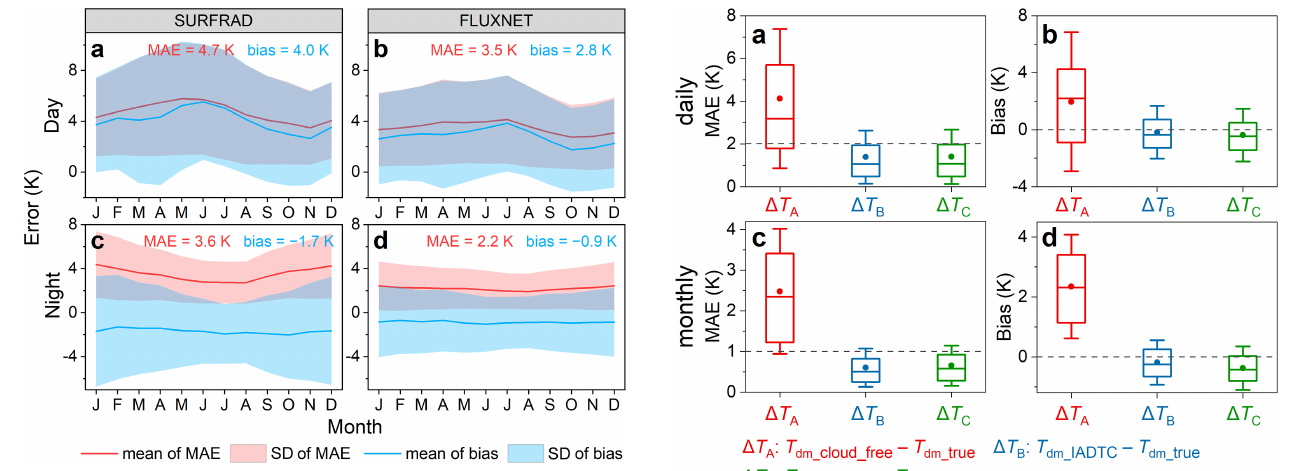
Figure 5. Validations of reconstructed under-cloud LSTs at Aqua and Terra day and night overpass times based exclusively on in situ data. The under-cloud LSTs were reconstructed with the ATC model. Panels (a) and (b) show monthly mean errors obtained for daytime overpasses (including Aqua day and Terra day) for SURFRAD and FLUXNET data, respectively; (c) and (d) show the same for the nighttime overpasses (including Aqua night and Terra night).